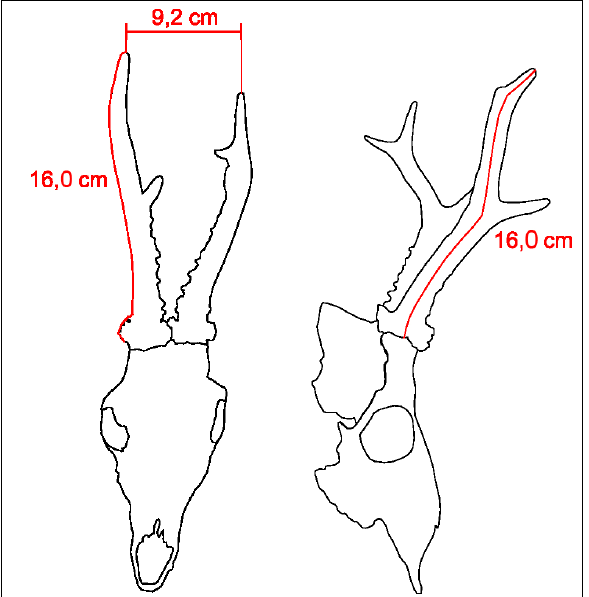
Figure 9. Antlers length and scale measured with the conventional